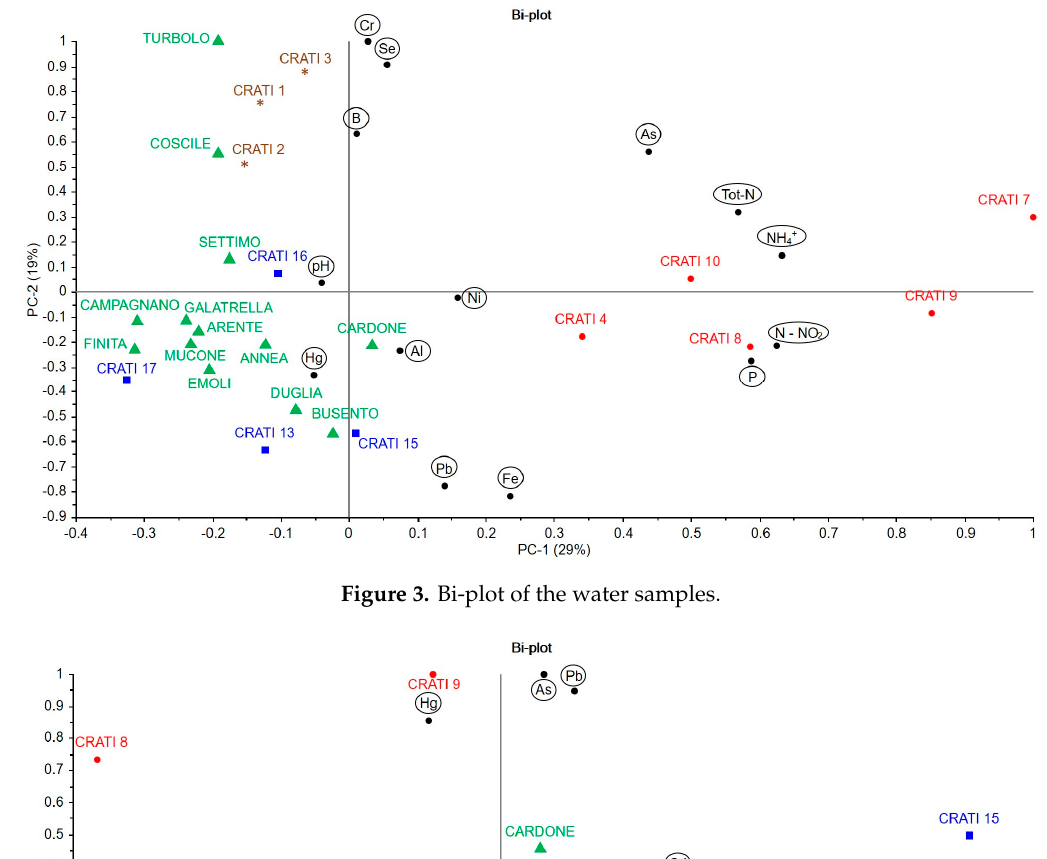
Figure 3. Bi-plot of the water samples. Water 2020 , 12 , x FOR PEER REVIEW